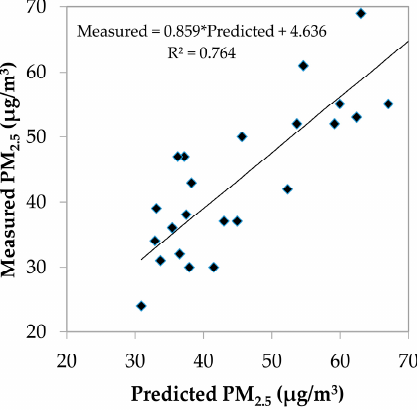
Figure 2. Predicted versus measured PM 2.5 concentrations of the test data set.